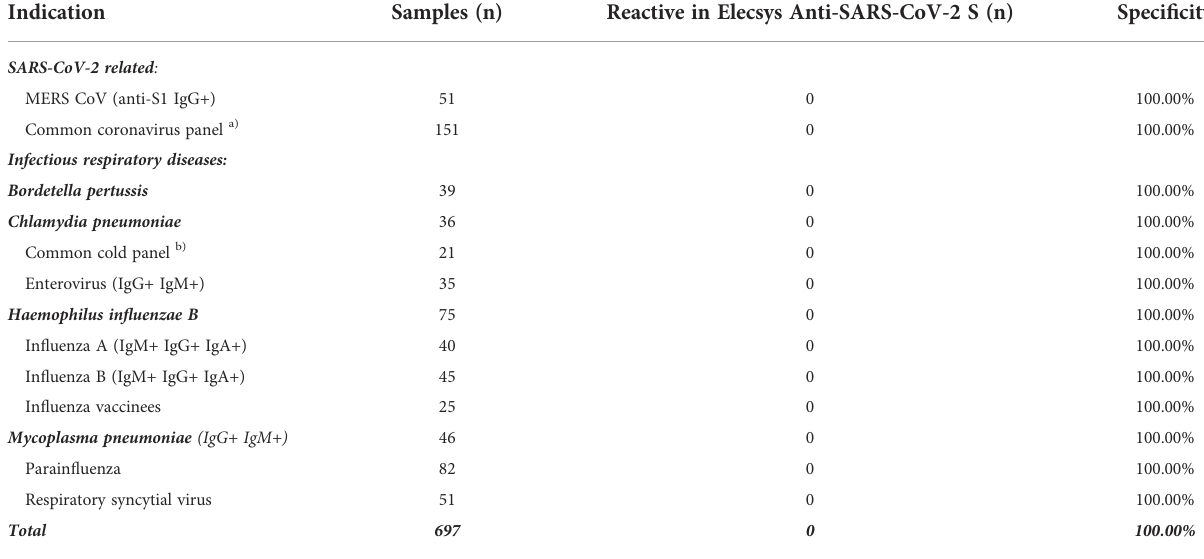
TABLE 2 Cross-reactivity of the ACOV2S assay in samples from participants with respiratory infections.